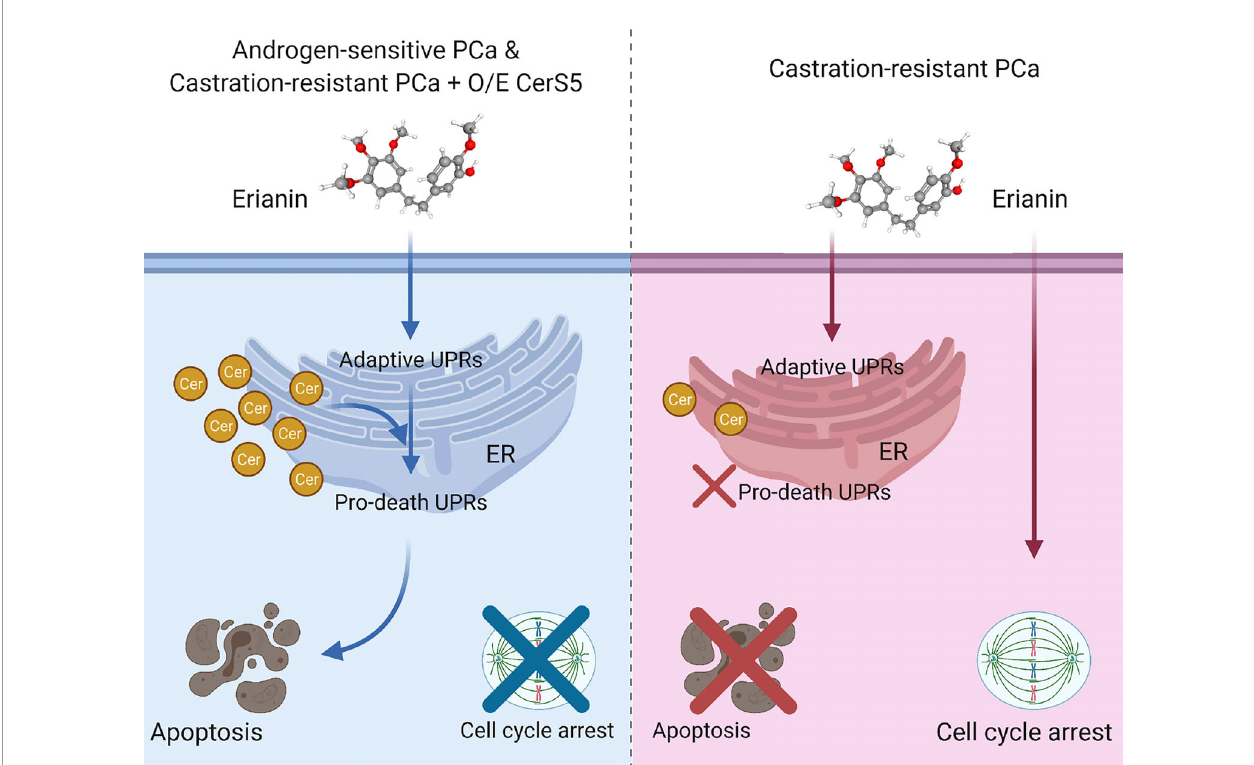
FIGURE 7 | Model depicting discrepant anti-tumor effects of erianin in androgen-sensitive and castration-resistant prostate cancer (PCa) cells, in which intracellular level of ceramide plays a critical role. Left panel: Androgen-sensitive PCa cells and ceramide synthase 5 (CerS5)-overexpressed castration-resistant PCa cells exhibit a high level of intracellular ceramide. Under this condition, erianin induces both adaptive and pro-death unfolded protein responses (UPRs) at the endoplasmic reticulum (ER), leading to apoptosis. Right panel: Castration-resistant PCa cells exhibit a low level of intracellular ceramide. Under this condition, erianin can only induce adaptive UPRs but not pro-death UPRs or apoptosis. Alternatively, erianin induces cell cycle arrest at the M phase. The diagram was created with BioRender.com. The 3D conformer of erianin was adapted from PubChem, https://pubchem.ncbi.nlm.nih.gov/compound/Erianin#section=3D-Conformer, PubChem CID